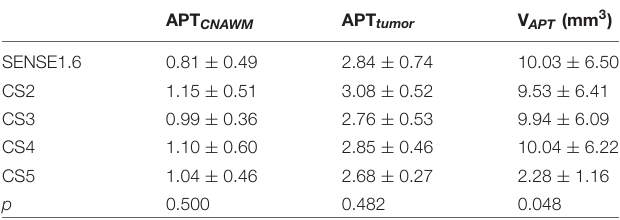
TABLE 3 | Comparisons of quantitative amide proton transfer (APT) values for meningiomas among CS and SENSE scans.